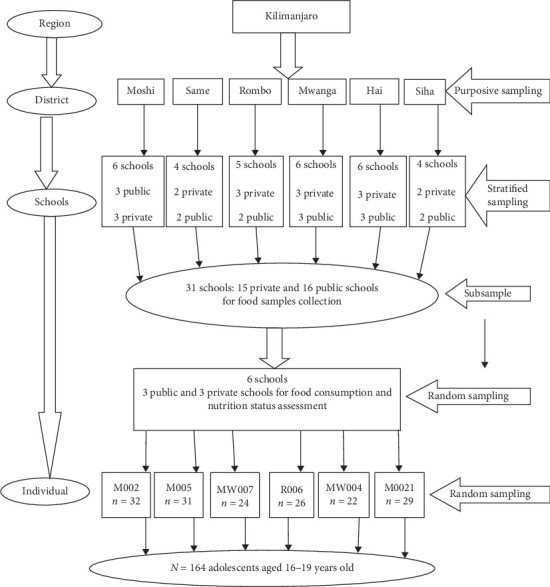
Schematic presentation of the sampling procedure.